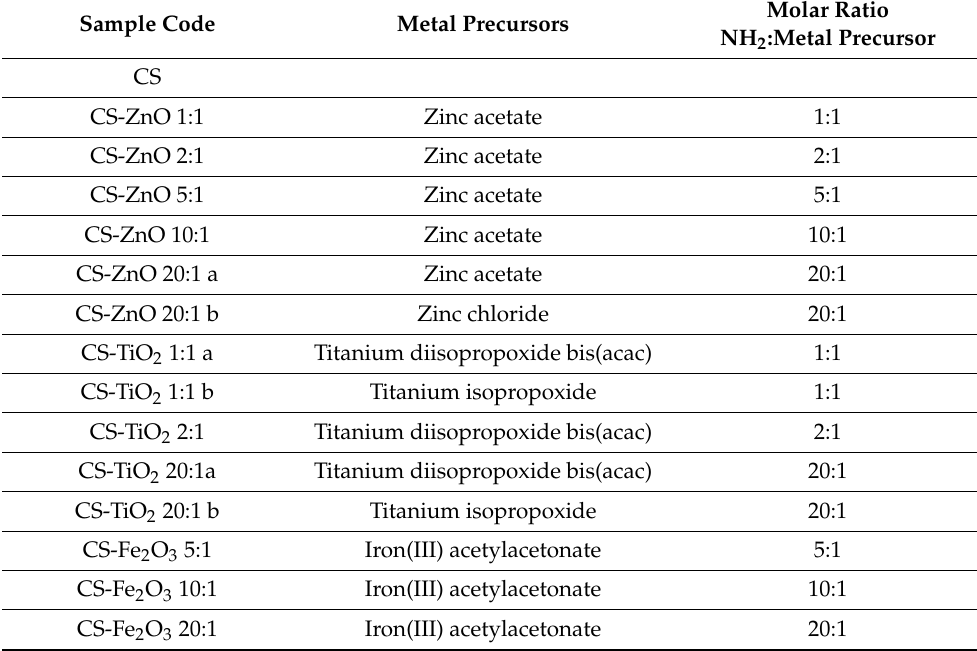
Table 1. Chemical composition of